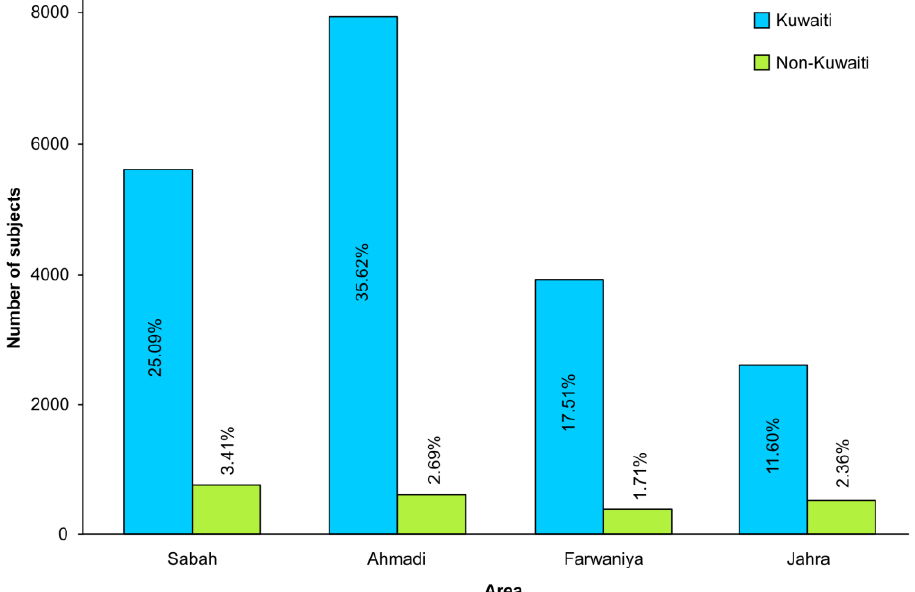
Figure 2. Percentages of screened Kuwaitis vs. Non-Kuwaitis according to the designated Premarital Reception Center.